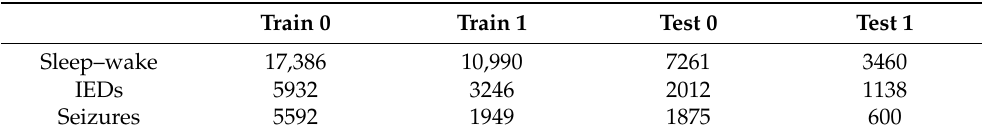
Table A1. Summary of the number of examples per dataset and category using examples with a 1